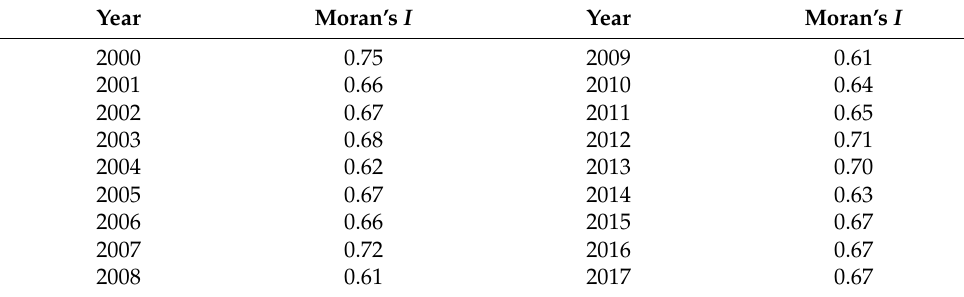
Table 2. Global Moran’s I of PM 2.5 concentrations from 2000–2017.